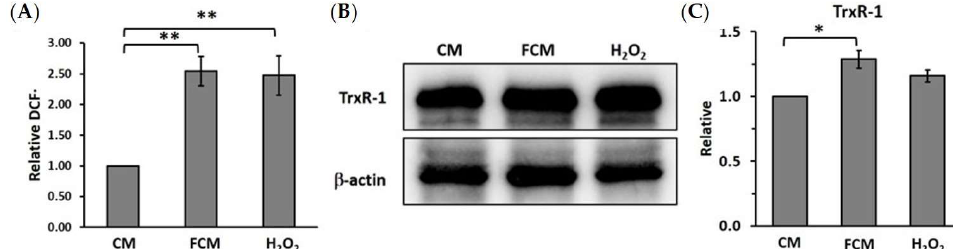
Figure 4. FCM induces cellular oxidant associated with TrxR-1 and cancer progression. ( A ) The relative proportion of cellular oxidant with the treated cell and control. ( B ) TrxR-1 was increased in FCM treated HCT116 that detected with Western blot. β -actin was used as loading control. ( C ) Relative intensity of protein band with β -actin and CM (control). The bar graph is represented with mean ± SD. * represents p ≤ 0.05 and ** represents p ≤ 0.01 compared between group. CM = complete media (control), FCM = fibroblast-cultured media, and 20 µ M H 2 O 2 as positive stress condition.